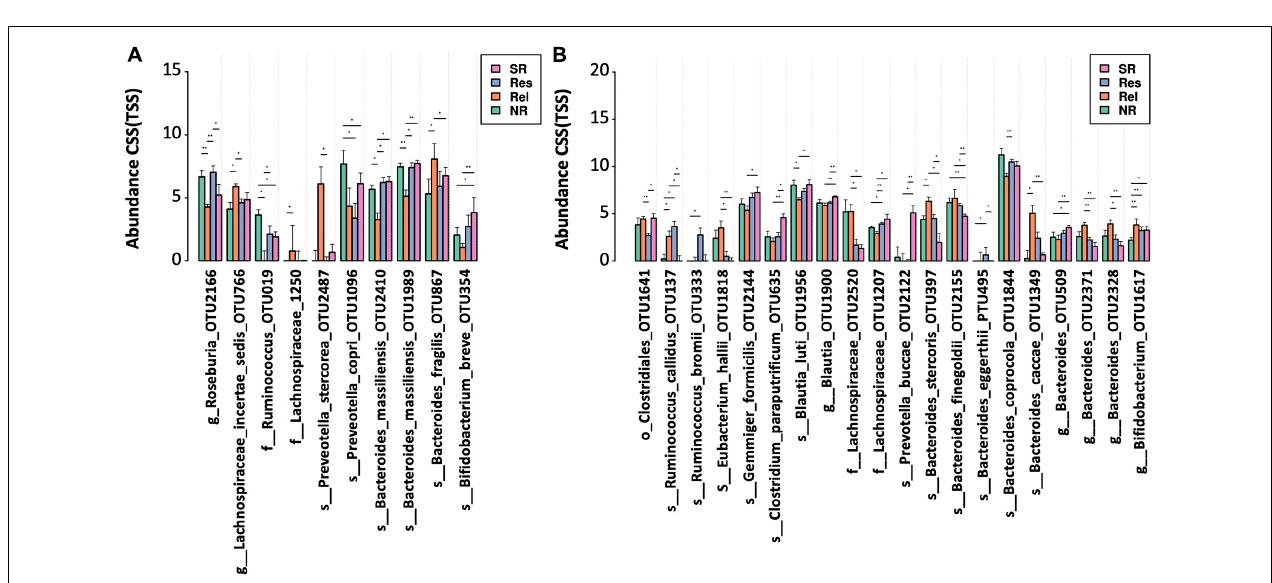
FIGURE 4 | The fecal microbiota composition of UC patients shifted by FMT. OTUs that were statistically different in abundance between F0 and F1, and between F0 and F2 (Wilcoxon rank-sum test p < 0.01). Heatmap is color-coded based on row z-scores. D, donor; F0, before FMT; F1, 2 ∼ 3 months after the first FMT, or before the second FMT; F2, 2 ∼ 3 months after the second FMT.